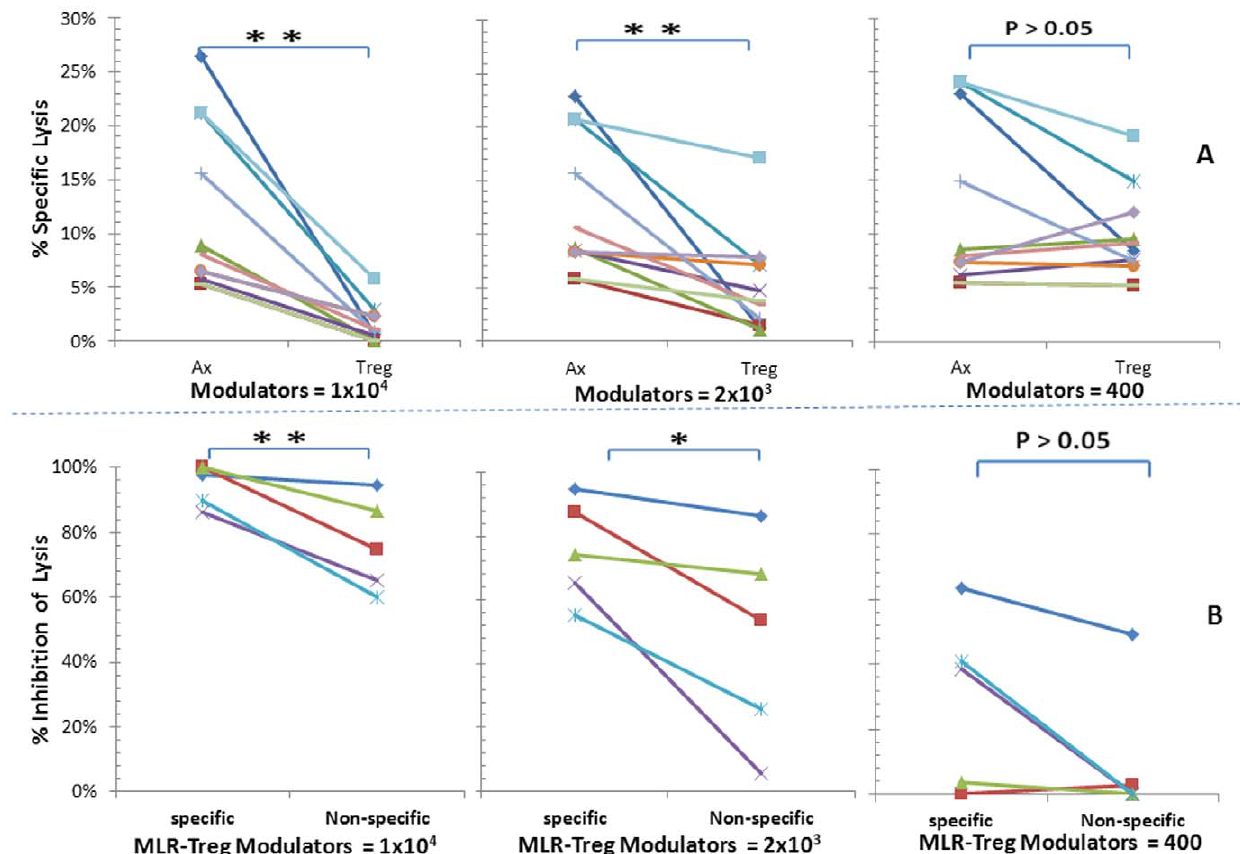
Figure 4. Regulatory effects of MLR-Tregs in micro-CML assays of responding whole PBMC. MLR-Tregs were added as modulators in descending concentrations of 1 6 10 4 , 2 6 10 3 or 0.4 6 10 3 cells per well to 1 6 10 5 fresh responding PBMC from the same individual as the one from whom MLR-Tregs were generated. These were stimulated with 1 6 10 5 irradiated allogeneic PBMC and 4-hour 51 Cr release assays against target cells from the stimulator were performed (as diagrammatically shown in Figure 1; step # 2, middle). The data are depicted as: (A) Percent specific lysis: against the specific stimulator used both in MLR-Treg generation and the micro-CML readout. Similar to the data shown in Figure 3, the inhibitory effects by MLR-Tregs are depicted by the points on the right, and the absence of inhibitory effects by modulator controls (Ax) is shown by points on the left side of each graph (**=p , .01; n=10). (B) Percentage inhibition: The percent specific lysis values were converted to percent inhibition (see Methods for this calculation). To test for specific inhibition, the stimulator/targets were from the original donor used for generating MLR-Tregs and for non-specific inhibition stimulator/target cells were from a third party donor. Note that allospecificity of CTL regulation is demonstrated with more significant inhibition at higher concentrations of MLR-Tregs in responses against stimulating cells from the original donor vs. those of the third party donor (**=p , 0.01; *=p , 0.05; n=5).